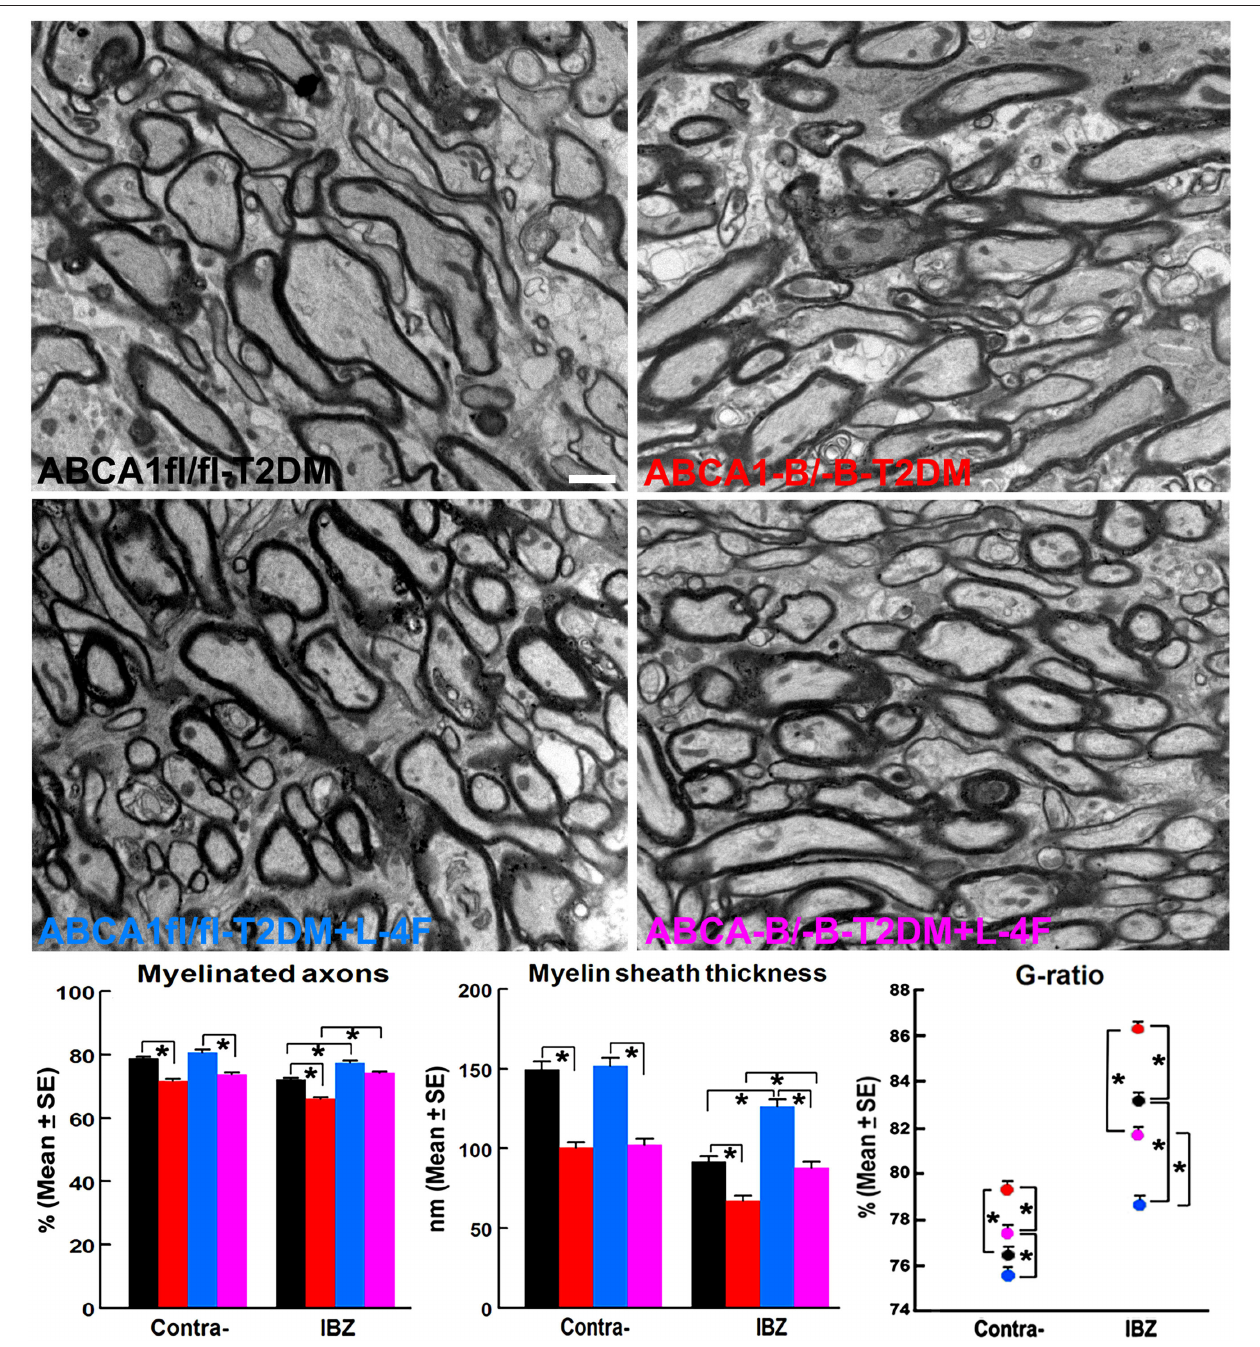
FIGURE 5 | L-4F treatment increases myelination identified by increased density of myelinated-axons, myelin-sheath thickness, and reduced G-ratio in the IBZ of WM-bundles of the ischemic brain at 21 days after stroke in T2DM mice. Scale bar = 1 µ m, * p < 0.05, n = 6/group.